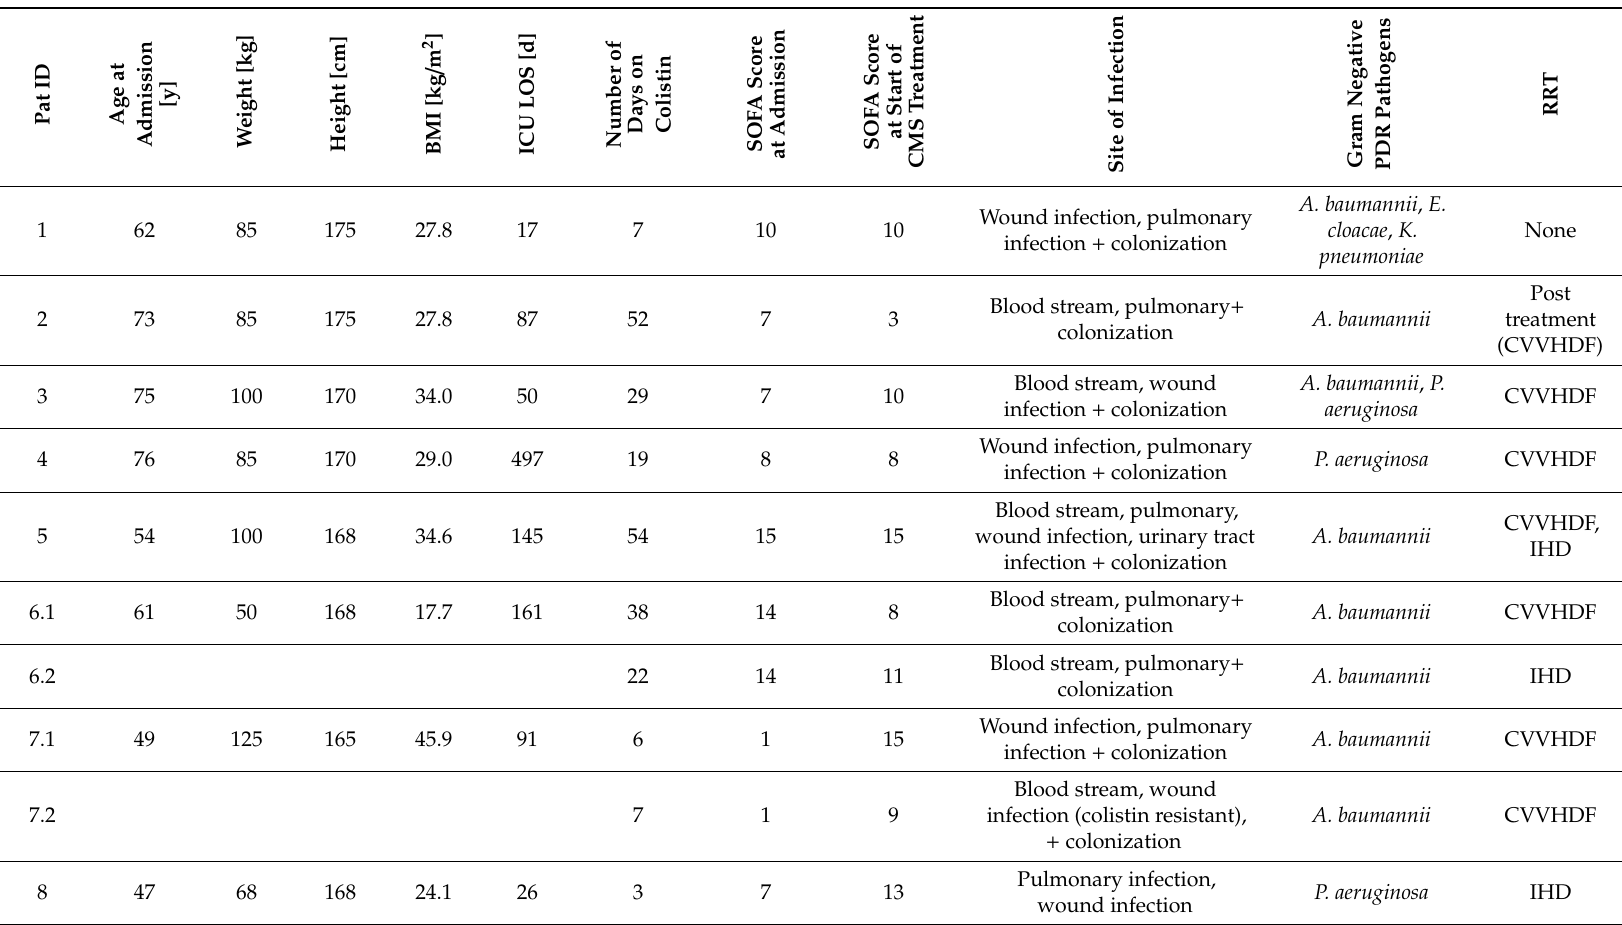
Table 1. Epidemiology and case specific details regarding infection, disease severity and need for renal replacement